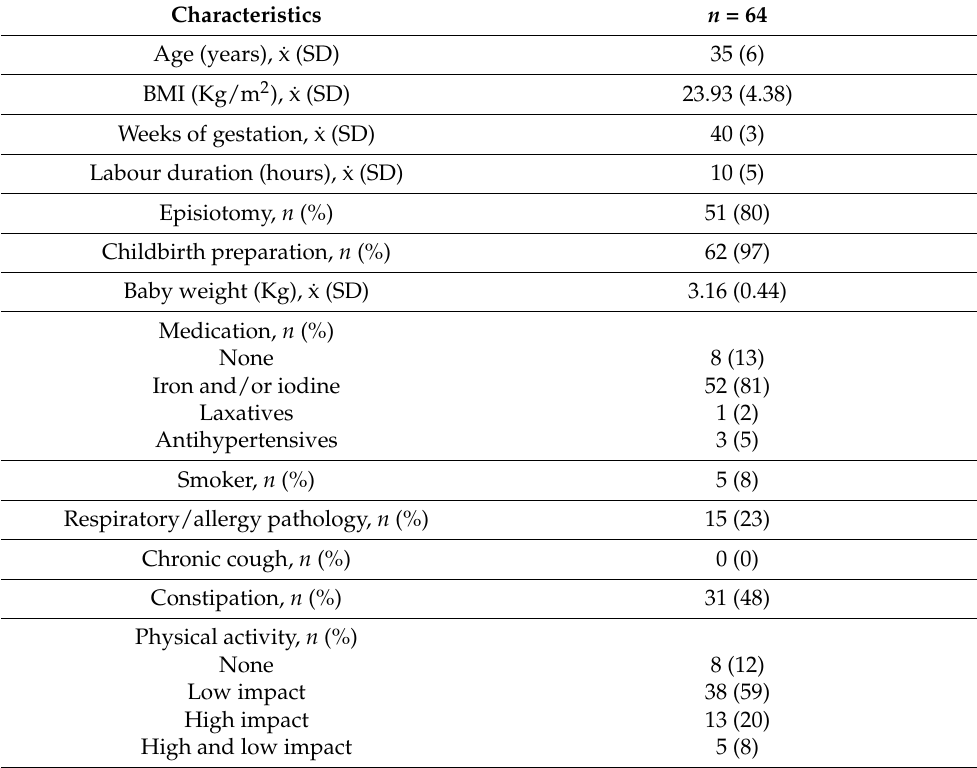
Table 1. Demographic characteristics of